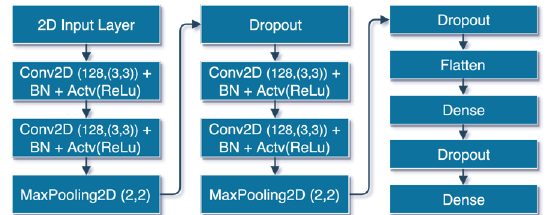
Figure 7. The employed 2D CNN architecture (number of filters and filter dimensions are given next to each layer).